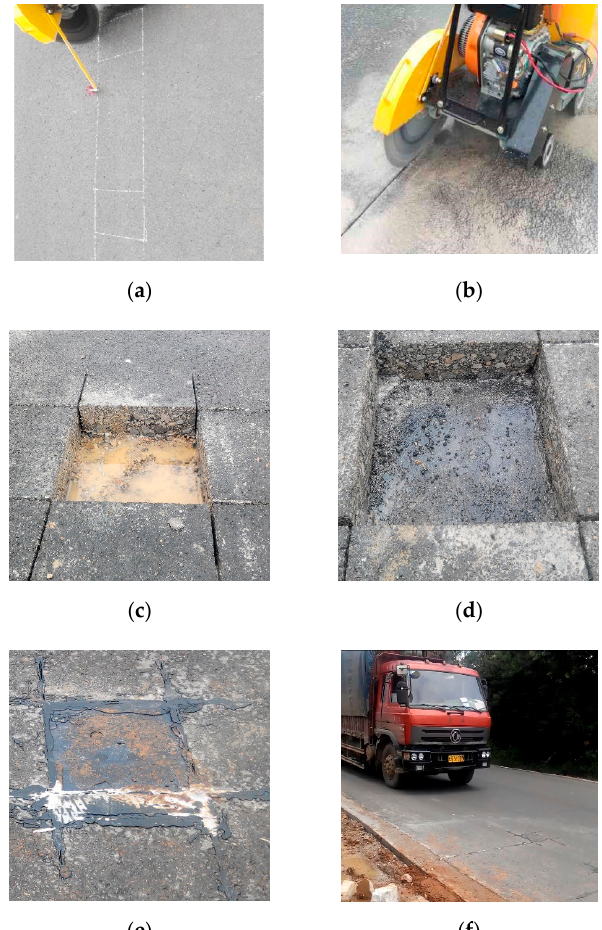
Figure 3. The flow chart of PEH installation: ( a ) positioning and scribing; ( b ) slotting; ( c ) coring for installation; ( d ) cleaning and levering the holes’ bottom; ( e ) putting PEHs in the pavement and laying the cable; ( f ) final state of the demonstration pavement.